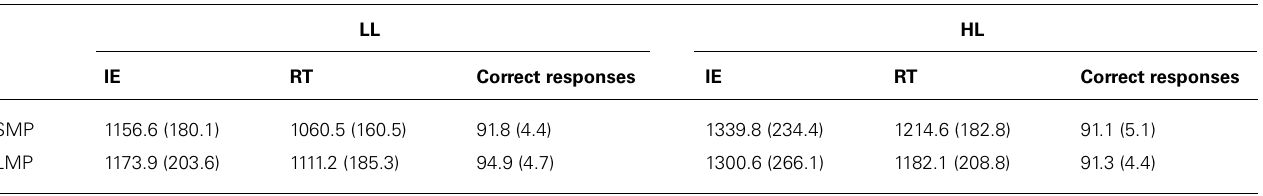
Table 1 | Summary of behavioral measurements.